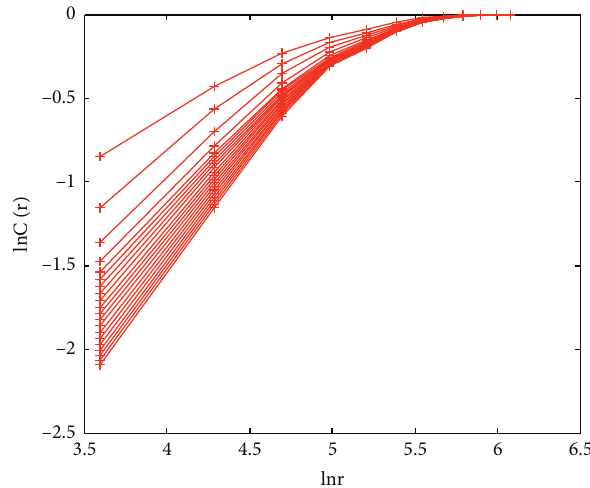
Figure 9: Distribution of nonrumor correlation integral.